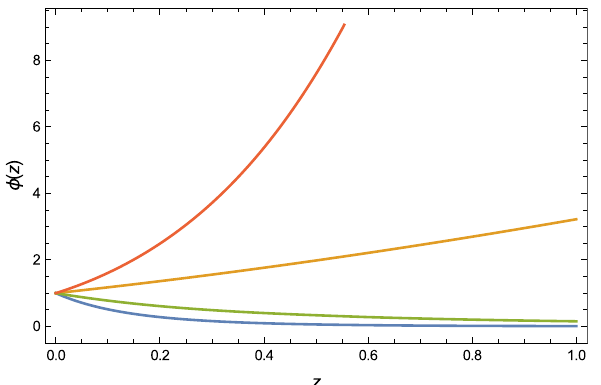
Fig. 3 Evolution of scalar field with respect to redshift for the power- law potential. The corresponding values of the index n are the same as in Fig. 1